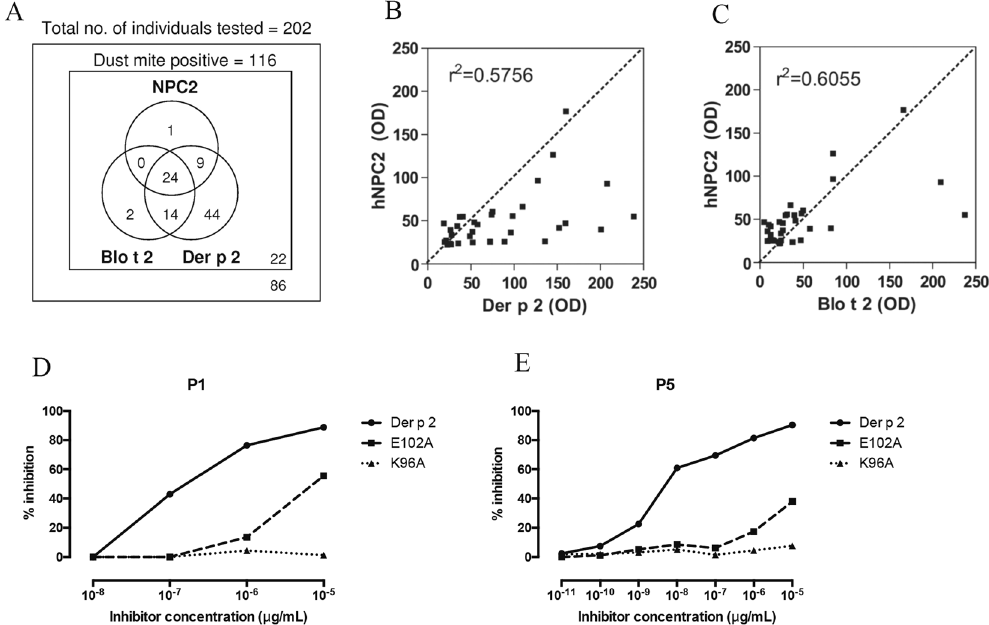
Figure 2. ( a ) Venn diagram (not to scale) of number of allergic individuals with IgE reactivity to Der p 2, NPC2 and Blo t 2 among individuals with allergic symptoms. IgE reactivity was measured using an immuno dot blot assay. Biplots of IgE reaction between ( b ) Der p 2 and hNPC2 or ( c ) Blo t 2 and hNPC2, among house dust mite allergic individuals was assayed using immuno dot blots and measured as optical density (OD). The coefficients of correlation are presented on each graph (p < 0.01). ( d , e ) Inhibition of IgE antibody binding from two representative allergic individuals between WT Der p 2 and its mutants are shown. Data presented are mean and standard deviations of two experiments.